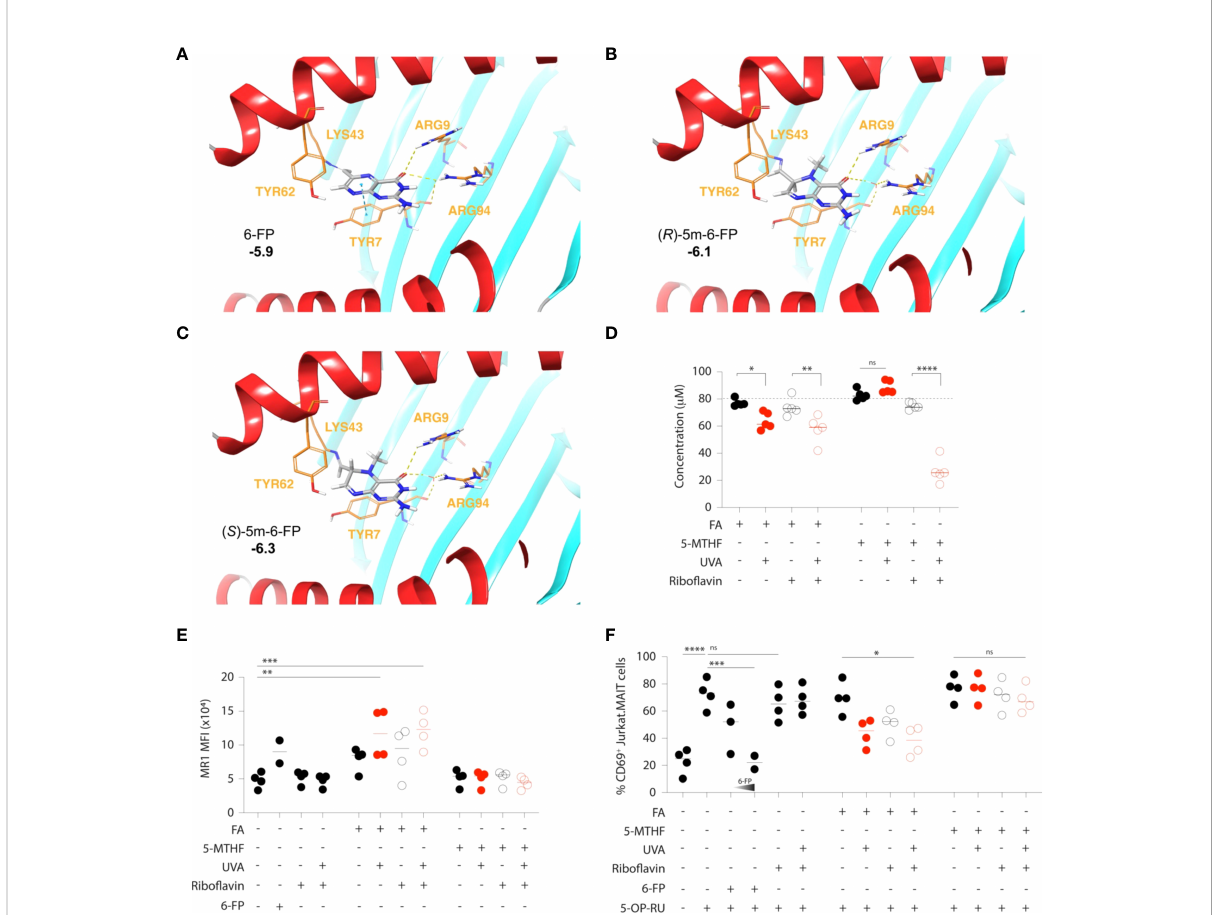
FIGURE 2 Inhibition of MAIT cell activation by folic acid, but not 5 – methylfolate, photometabolites. (A – C) Docked conformation of 6 – FP (A) , ( R ) – 5m – 6 – FP (B) and ( S ) – 5m – 6 – FP (C) to the MR1 binding site. Cdock af fi nity scores are highlighted in bold. The carbonyl of 6 – FP interacts with the positively charged residues ARG9 via hydrogen bonding and ARG94 via water mediated hydrogen bonding. A p – stacking interaction with TYR7 is also observed. The ( R ) and ( S ) 5 – m – 6 – FP enantiomers show similar positioning within the pocket but have no p – stacking interaction with TYR7. Ligand carbons are marked in grey while protein carbons are marked in orange. Hydrogen bonding and hydrophobic interactions are depicted as yellow and blue dashed lines, respectively. (D – F) Folic acid (FA) and 5 – methyltetrahydrofolate (5 – MTHF) solutions (80 m M in PBS) were exposed to UVA radiation in the presence or absence of equimolar amounts (80 m M) of the natural photosensitizer ribo fl avin. The extent of their respective photodegradation was determined by UV – Vis spectrophotometry (D) . The release of inhibitory MR1 ligands was assessed by the staining intensity (as mean fl uorescence intensity, MFI) of cell surface MR1 on antigen presenting (C1R.MR1) cells (E) and the associated inhibition of 5 – OP – RU – mediated activation of a MAIT cell line (Jurkat.MAIT), as determined by the expression of the activation marker CD69 (F) . 6 – FP (5 m M and 10 m M) was used as a control. Each symbol represents the mean value of an independent experiment (2 – 4), each run in triplicates. Statistics were calculated using one – way ANOVA with Tukey post – test, * p<0.05, ** p<0.01, *** p<0.001, **** p<0.0001, ns = non – signi fi